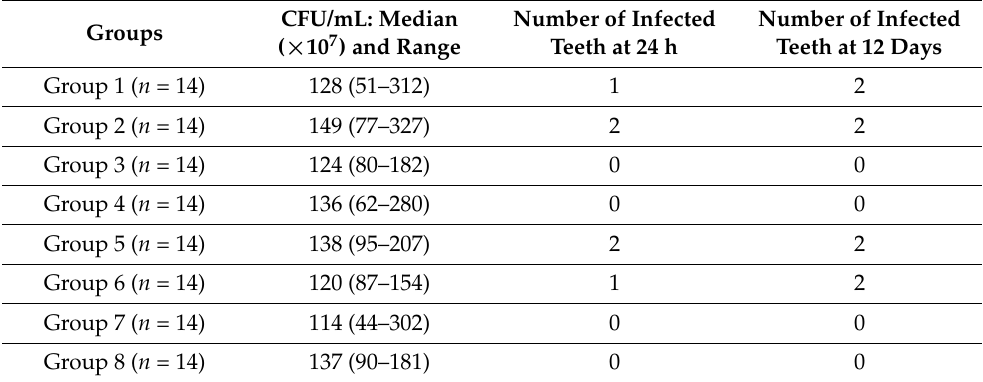
Table 1. Median and range specimens CFU prior to the treatment and number of infected teeth at 24 h and at day 12 after